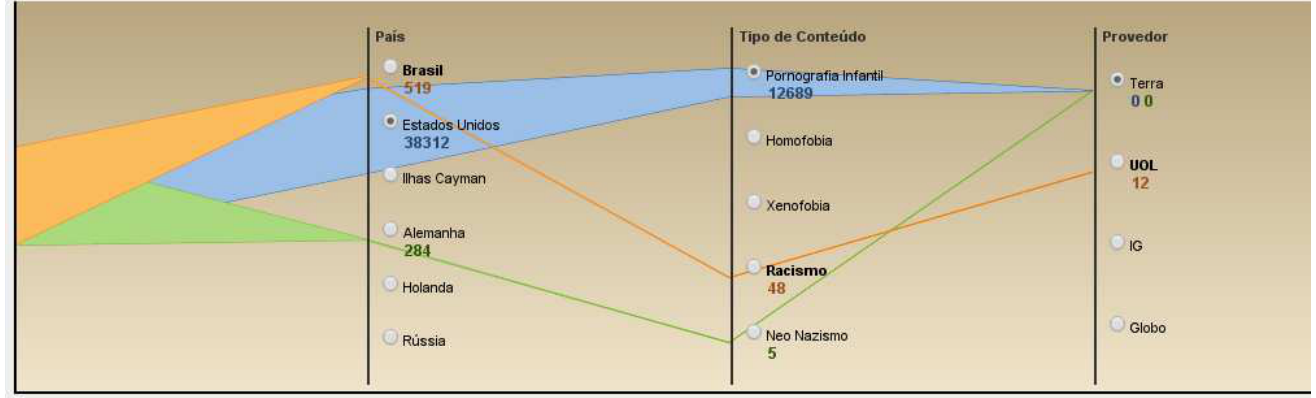
Fig. 13. Common datafile represented in parallel bars: all three non-numeric variables and one numeric variable (total reports) are represented in this chart